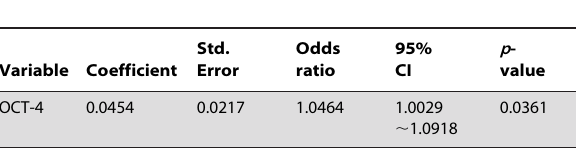
Table 5. Multiple logistic regression analysis for risk factor in terms of